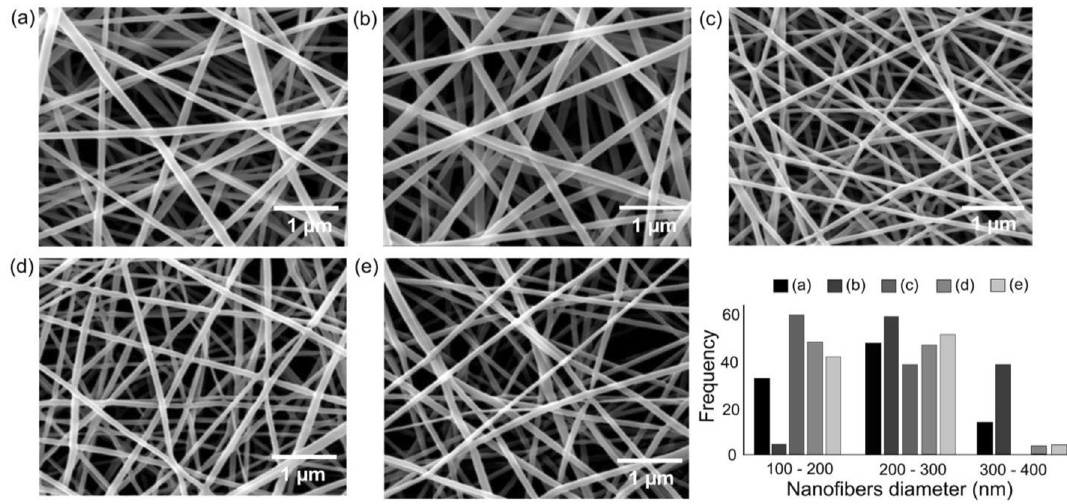
Figure 3. SEM morphologies and fiber diameter histograms for ( a ) PVA, ( b ) PVA/EGF, ( c ) PVA/FGF, ( d ) PVA/ EGF-FGF and ( e )